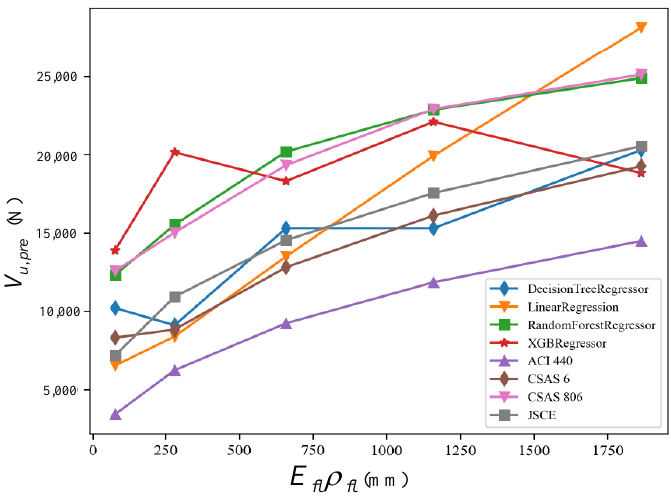
Figure 14. Effects of axial rigidity of FRP reinforcement 𝐸 𝑓𝑙 𝜌 𝑓𝑙 on shear performance.